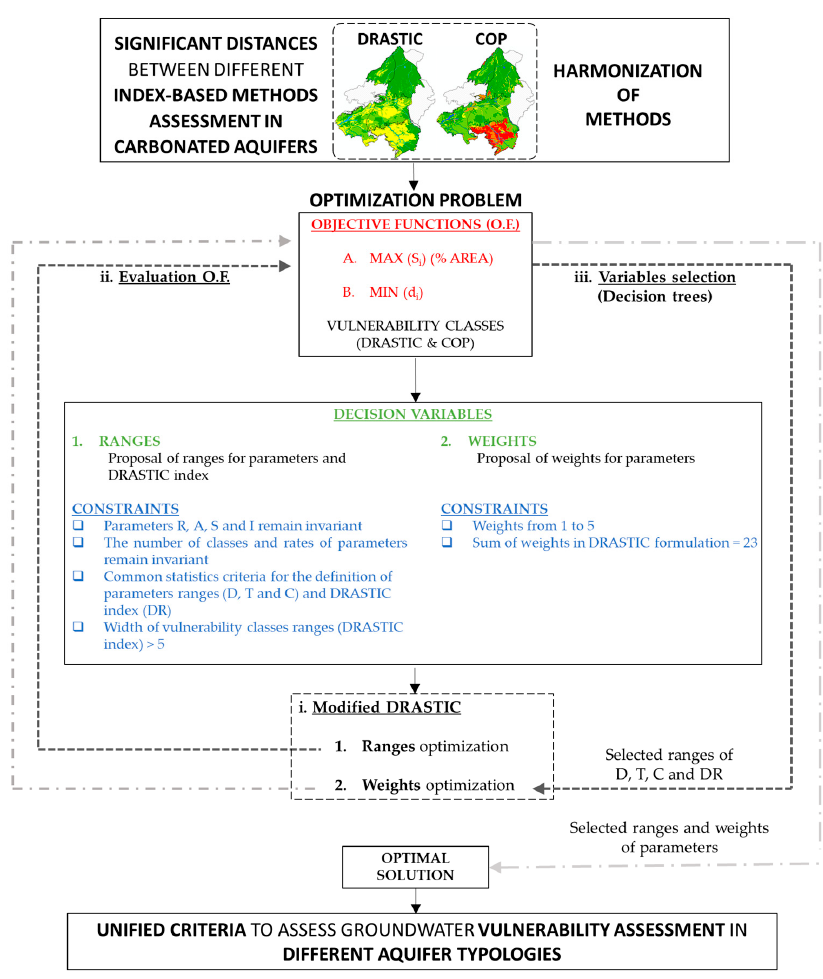
Figure 4. Flowchart of methodology.